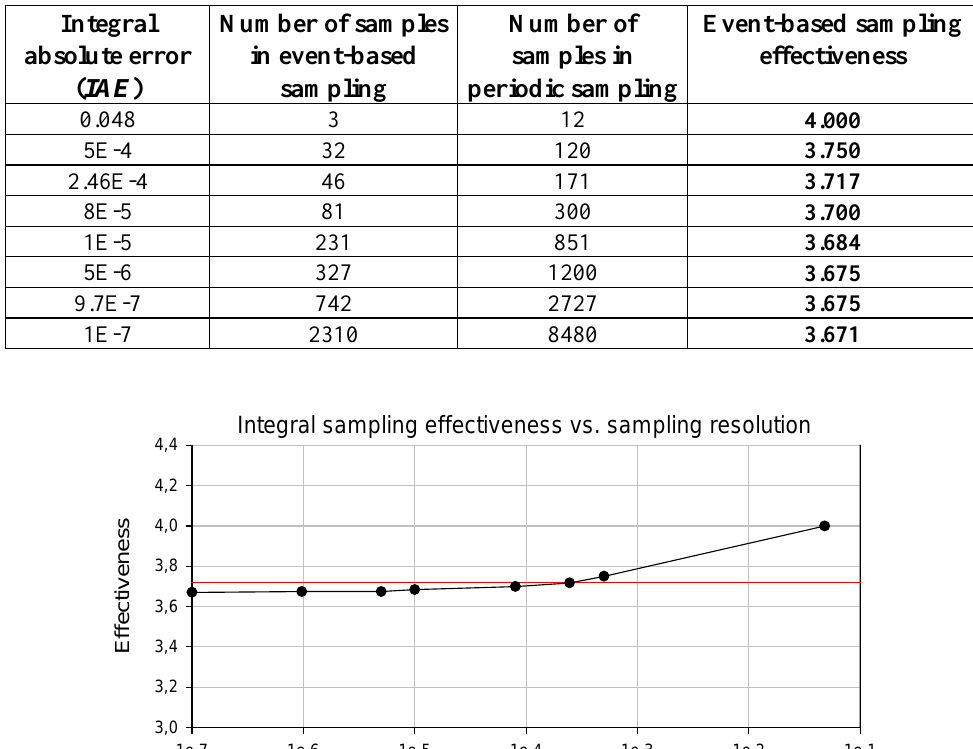
Table 2. Simulation results of the integral sampling effectiveness for the signal tested.